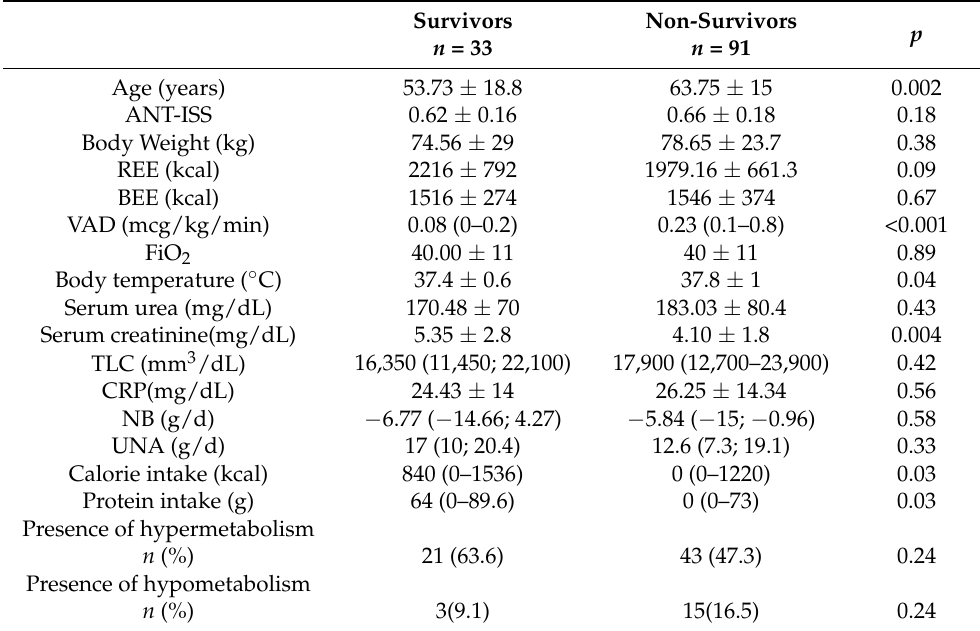
Table 5. Characteristics of severe AKI patients according to 28-day